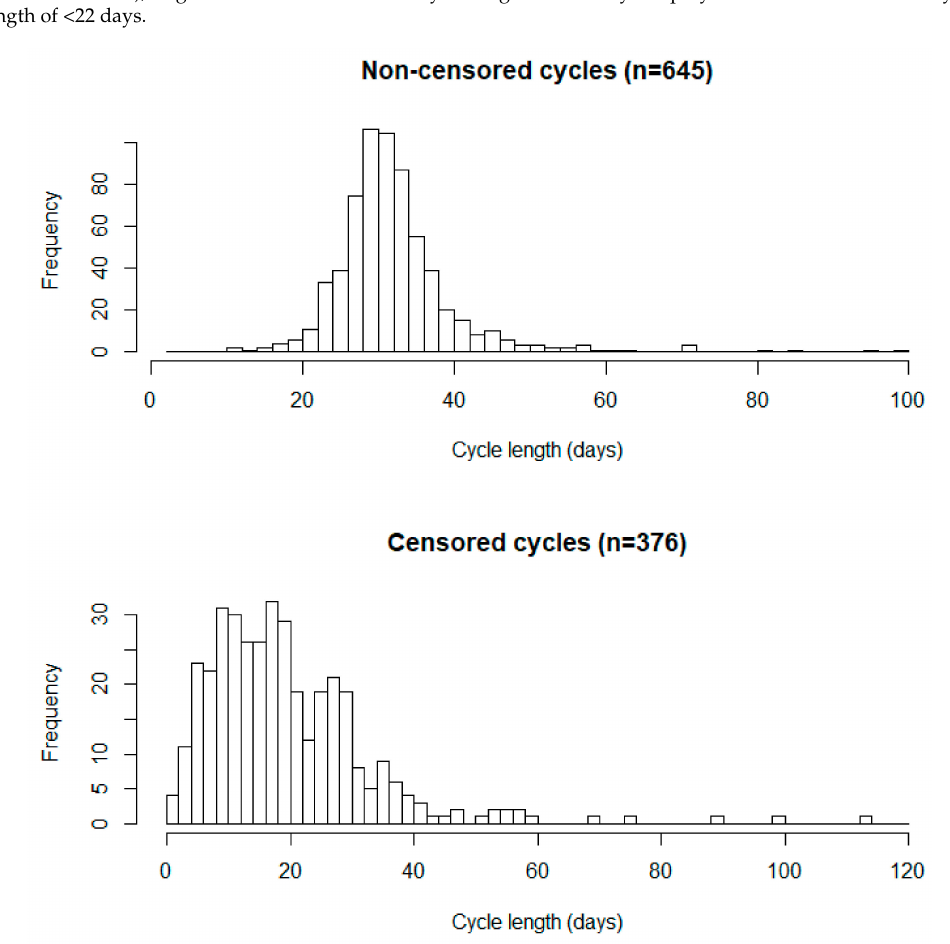
Figure 1. Distribution of cycle length for n = 645 noncensored and n = 376 censored